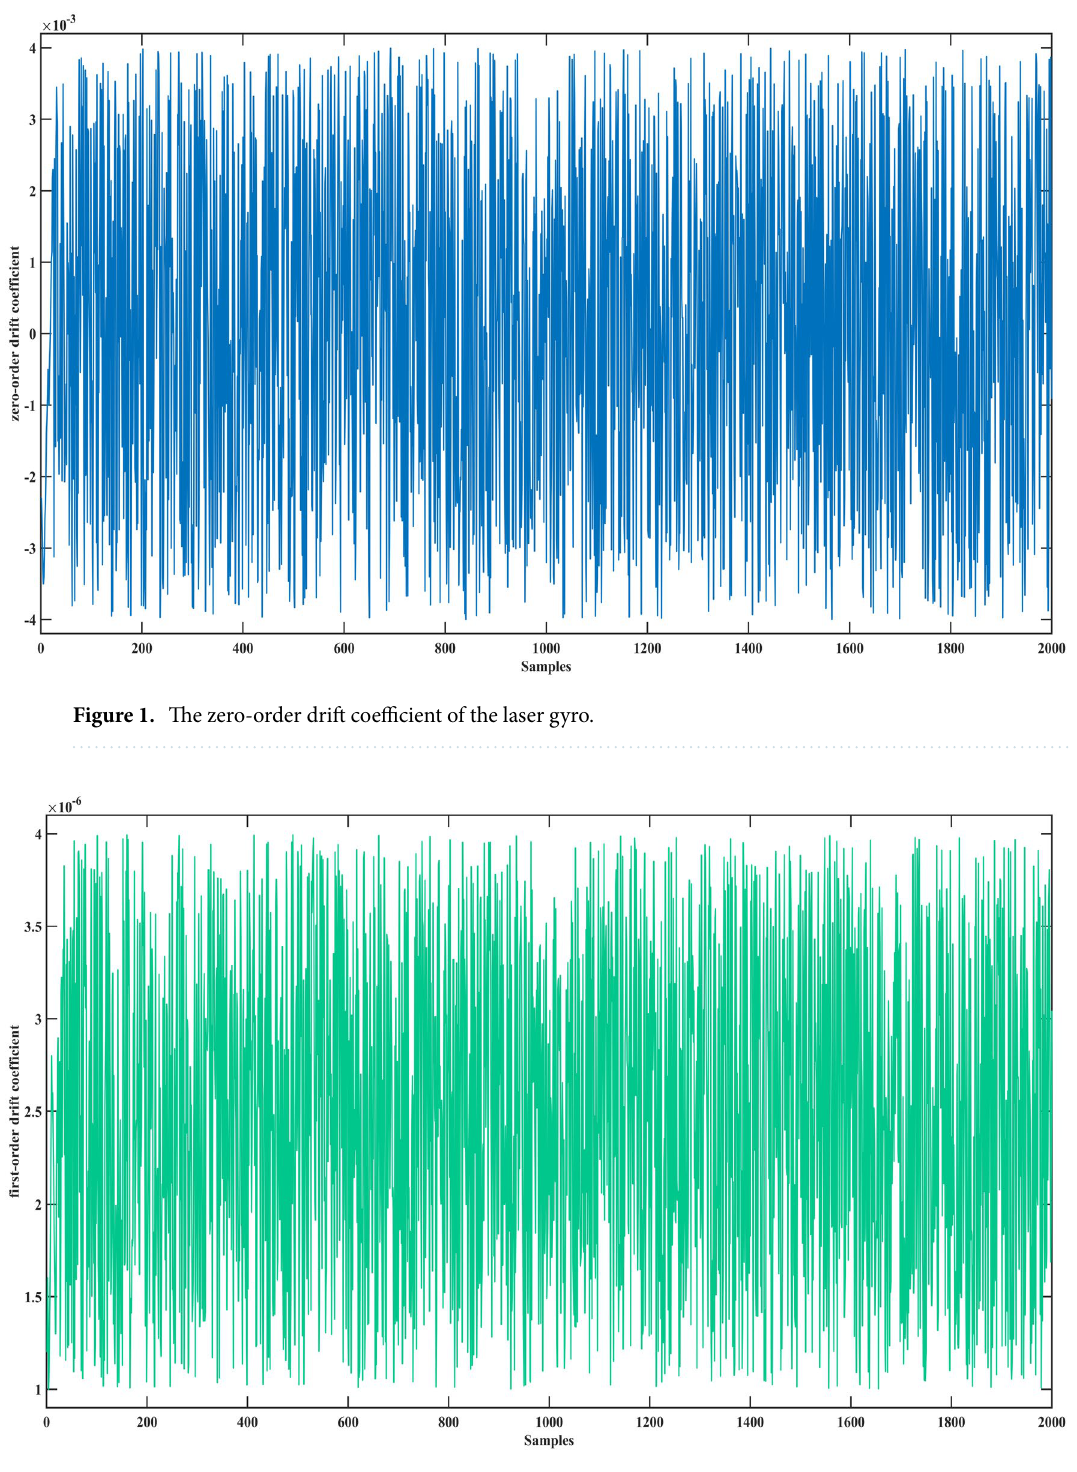
Figure 2. The first-order drift coefficient of the laser